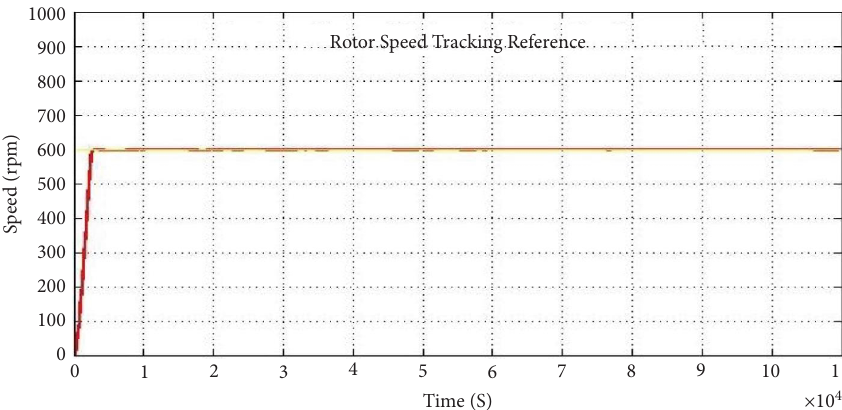
Figure 18: Rotor speed tracking the reference (600) of the nominal speed of the motor.